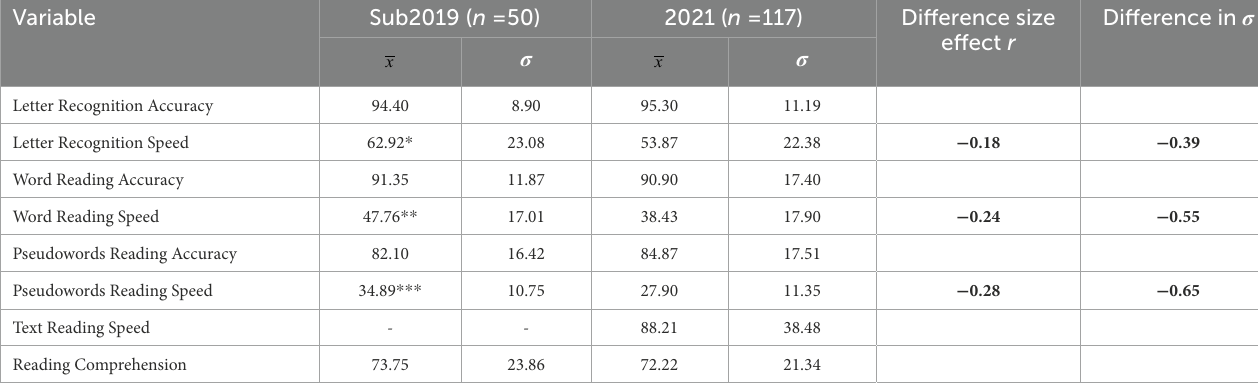
TABLE 3 Results in reading performance variables in fourth grade, pre- and post-pandemic.